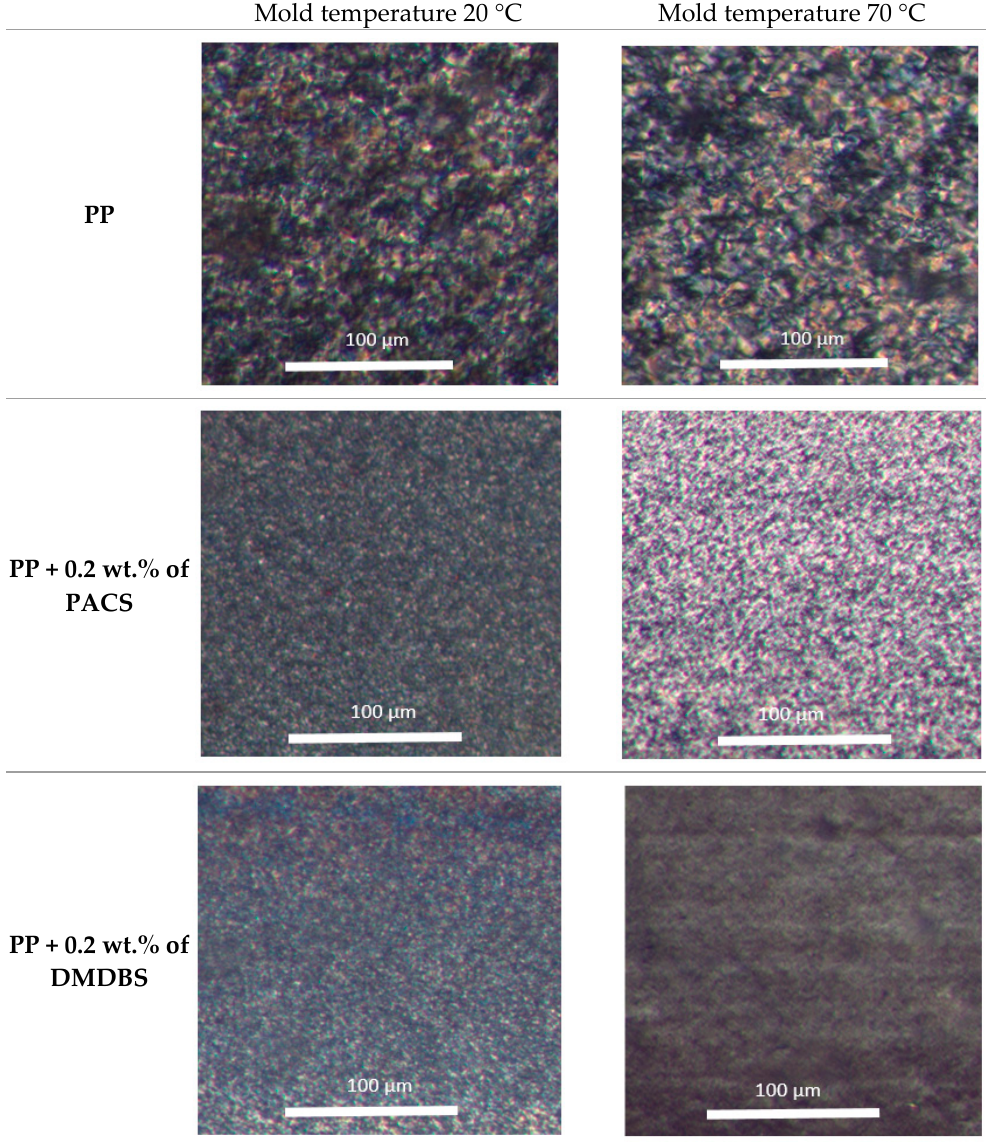
Figure 1. The microscopic observations by polarized light (POM).